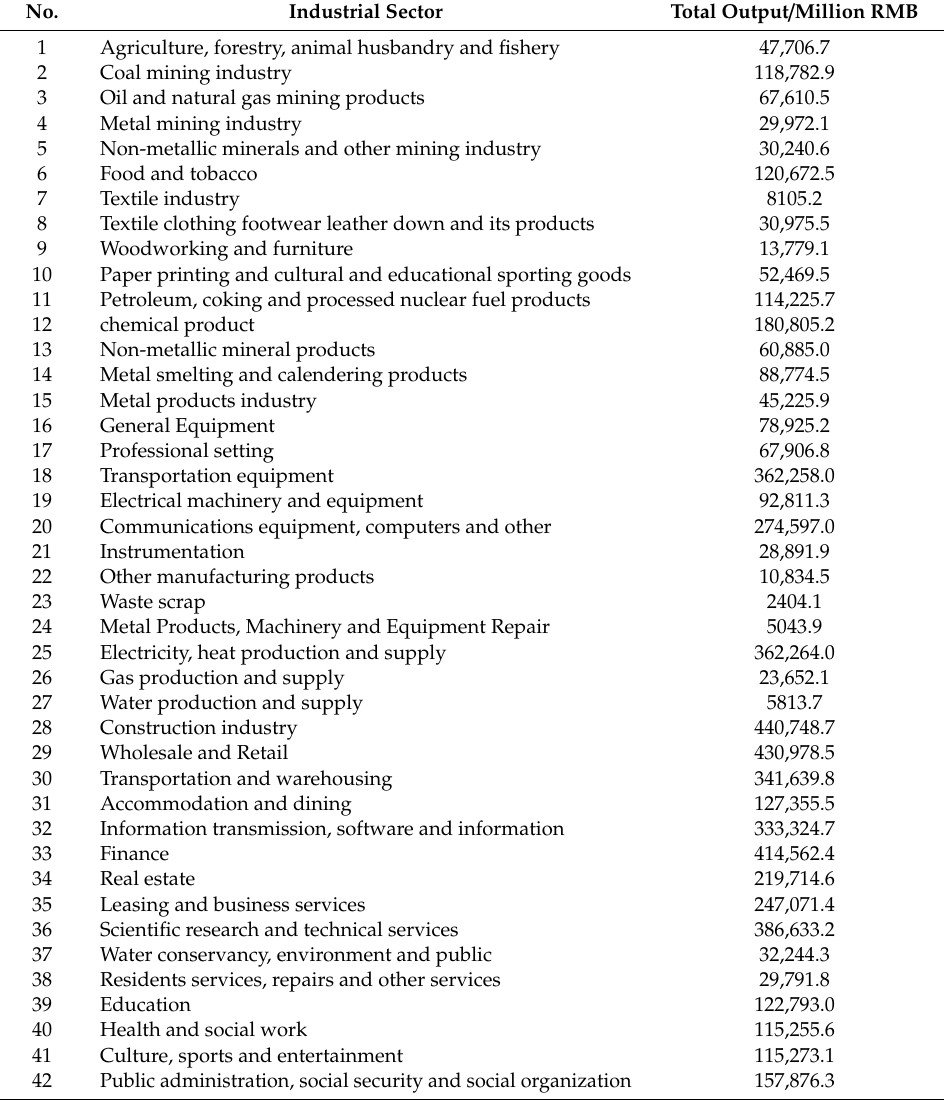
Table 2. Predicted total output for each industrial sector in